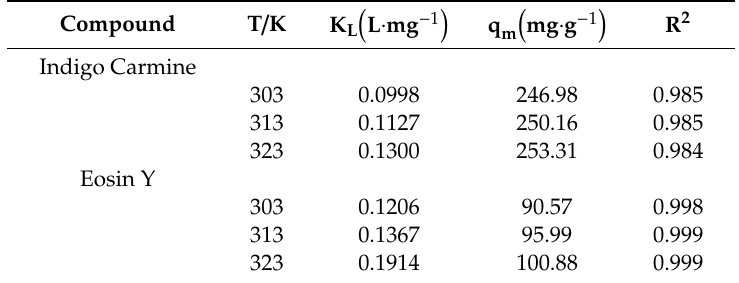
Table 3. Summary of the Langmuir correlation constants.